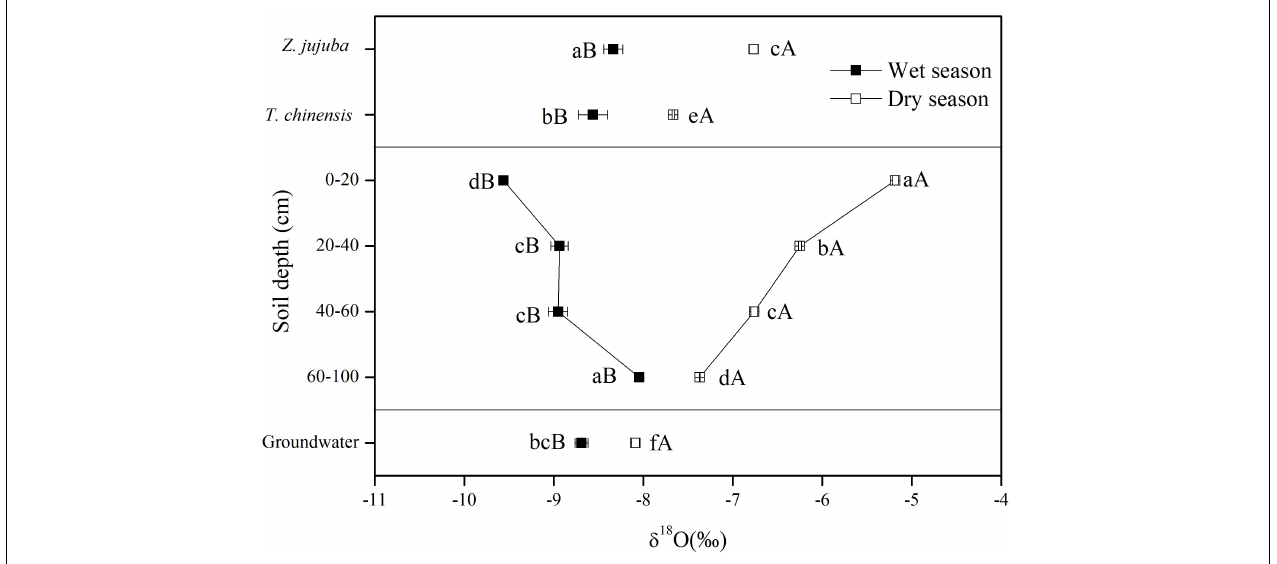
FIGURE 4 | δ 18 O values of potential water sources and plant xylem water for dry and wet seasons. Error bars represent standard errors of mean δ 18 O ( n = 9). Different lowercase letters represent the significant difference in δ 18 O values among different samples in dry or wet seasons at the 0.05 level. Different capital letters represent significant difference in δ 18 O values of each sample between dry and wet seasons at the 0.05 level.